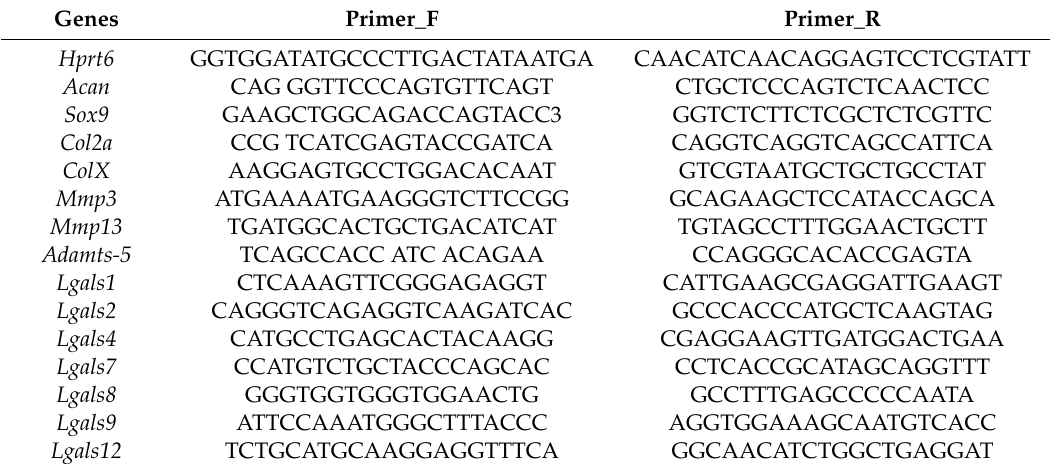
Table 3. Primer sequences of di ff erent